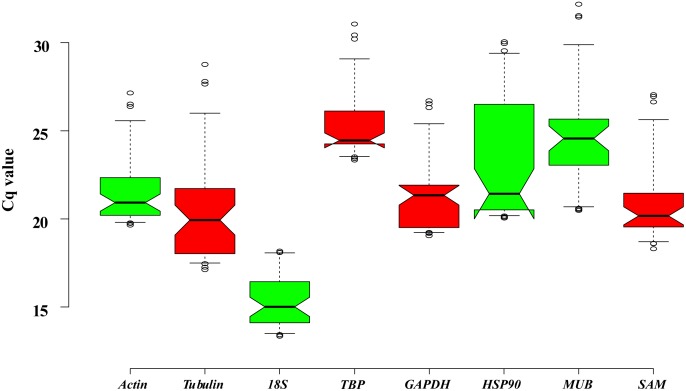
Expression levels of eight candidate reference genes across all experimental samples. Distribution of Cq values of candidate reference genes in all samples. Boxplots show the 25 and 75th percentiles, mean, and outliers.